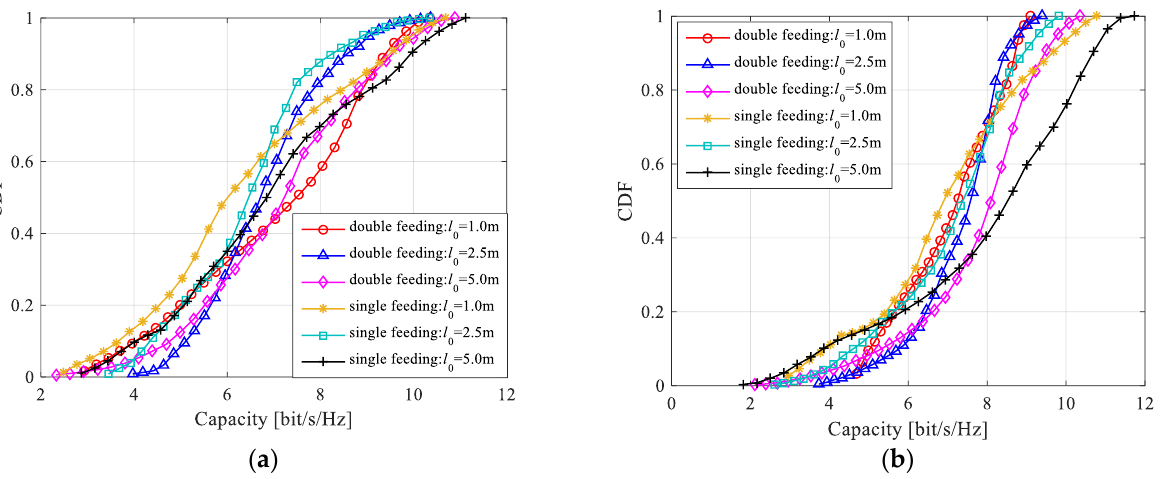
Figure 12. Channel capacity of the MIMO system for double-port fed and single-port fed LCX: ( a ) LoS propagation path; ( b ) both LoS and NLoS propagation paths.